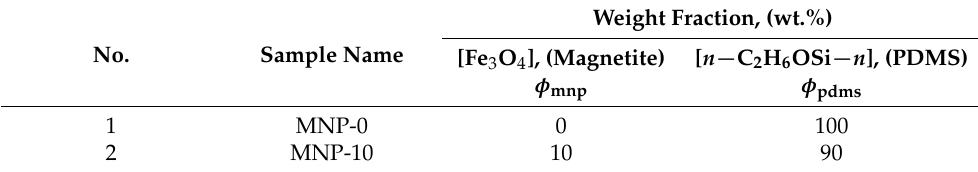
Table 1. Composition of the implant specimens.